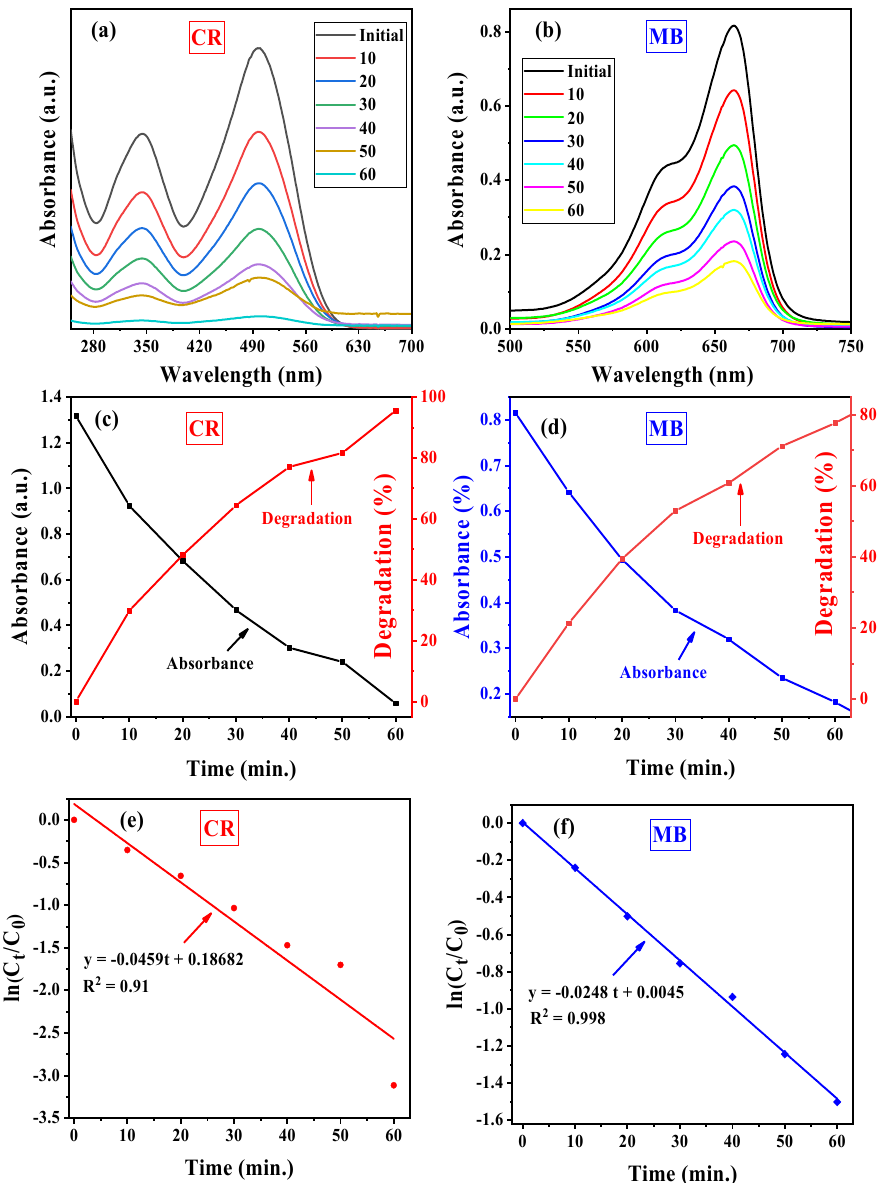
Figure 6. Decrease in absorption intensity with time ( a , b ), absorbance and degradation percentage ( c , d ) and kinetics plots ( e , f ) for the degradation of CR and MB dyes, respectively, in 1 h of irradiation under visible light utilizing rGO-CuO nanocomposites as a catalyst. Table 2. Summary of photocatalytic parameters for the degradation of CR and MB dyes using rGO/CuO nanocomposites. S/N Dye D ( % ) 𝒕 (𝐦𝐢𝐧. ) 𝜿 𝒂𝒑𝒑 (𝐦𝐢𝐧. (cid:2879)𝟏 ) 𝒕 𝟏 𝟐⁄ (𝐦𝐢𝐧. ) R 2 1